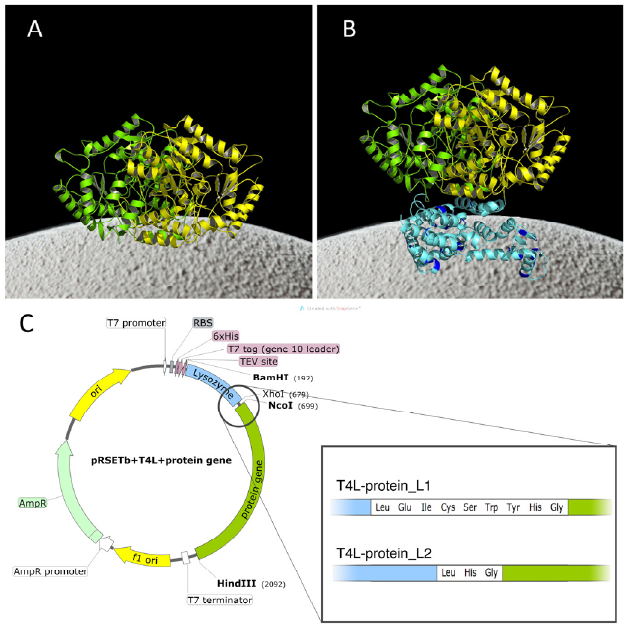
Figure 1. Proposed architecture of HEWT (green and yellow represent the two enzyme subunits) in covalent bonding directly on the solid support surface ( A ) or mediated by a linker protein (light blue, in dark blue the reactive lysines) ( B ). pRSET ‐ b construct map outlining T4L (blue) and the protein gene (green). The inset shows the sequences of the two aminoacidic linkers separating the lysozyme and the target protein ( C ).